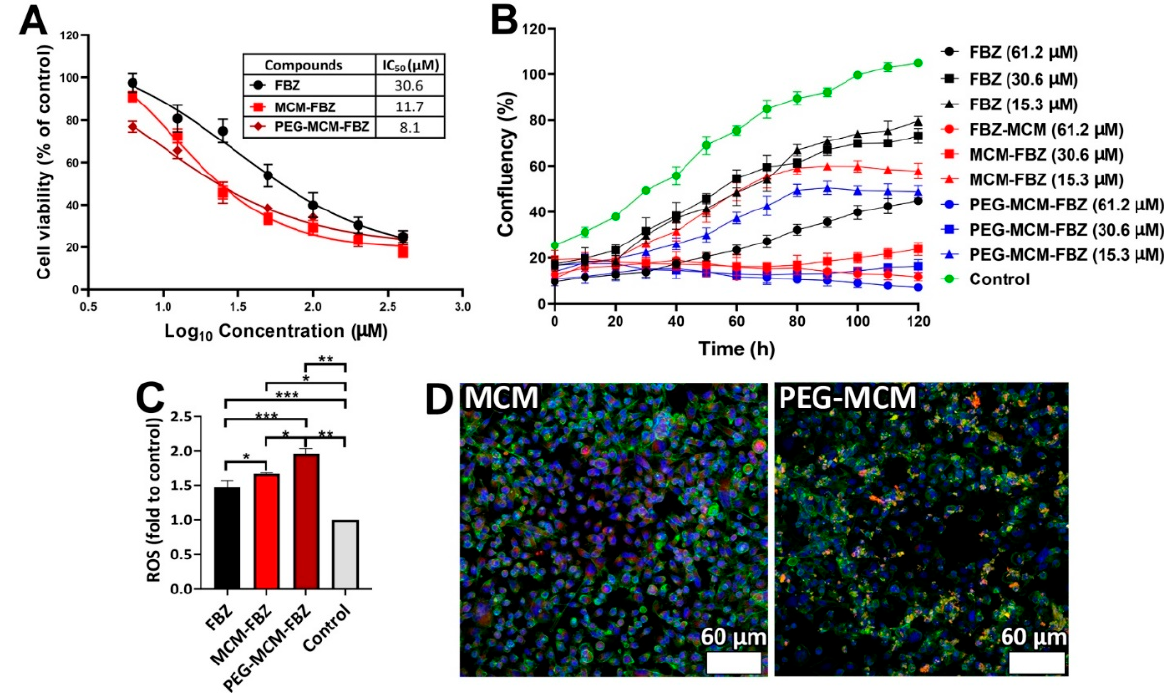
Figure 5. ( A ) Cell viability effects of different concentrations of FBZ, MCM ‐ FBZ, and PEG ‐ MCM ‐ FBZ NPs against prostate cancer PC ‐ 3 cells after 48 h incubation. The data are expressed as mean ± SD ( n = 3). ( B ) ROS generation after PC ‐ 3 cells’ incubation with FBZ, MCM ‐ FBZ, and PEG ‐ MCM ‐ FBZ NPs for 6 h. Data are expressed as mean ± SD from three independent experiments and were analyzed using a t ‐ test: * p < 0.05; ** p < 0.01, *** p < 0.001. ( C ) The cell proliferation assay of PC ‐ 3 cells in 5 days. ( D ) Fluorescence microscope images of PC ‐ 3 cells after incubation with MCM ‐ Cy5 and PEG ‐ MCM ‐ Cy5 NPs for 4 h.